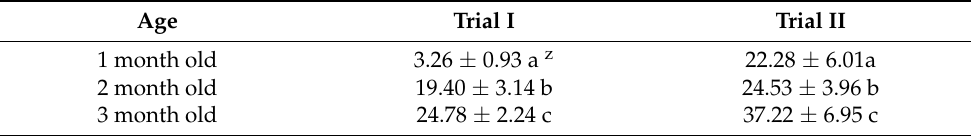
Figure 2. Effect of 1-, 2-, and 3-month-old SSgH biomass on the number of root-knot nematode females on mustard green roots in Trial I ( a ) and Trial II ( b ). NA (no amendment), BK (Bundle King), MII (Monster II), BKP (Big Kahuna Plus), CV (Cow Vittles), SH (sunn hemp), 512 (512 × 14), LBMR (Latte BMR), 535 (535 × 14), LA (Latte), NX1 (NX 4264), and NX2 (NX-D-61). Means ( n = 12) followed by the same letter(s) are not different according to Waller–Duncan k -ratio ( k = 100) t - test. Table 2. Effect of SSgH age on the development of root-knot nematode female in roots of mustard green in the greenhouse trials.